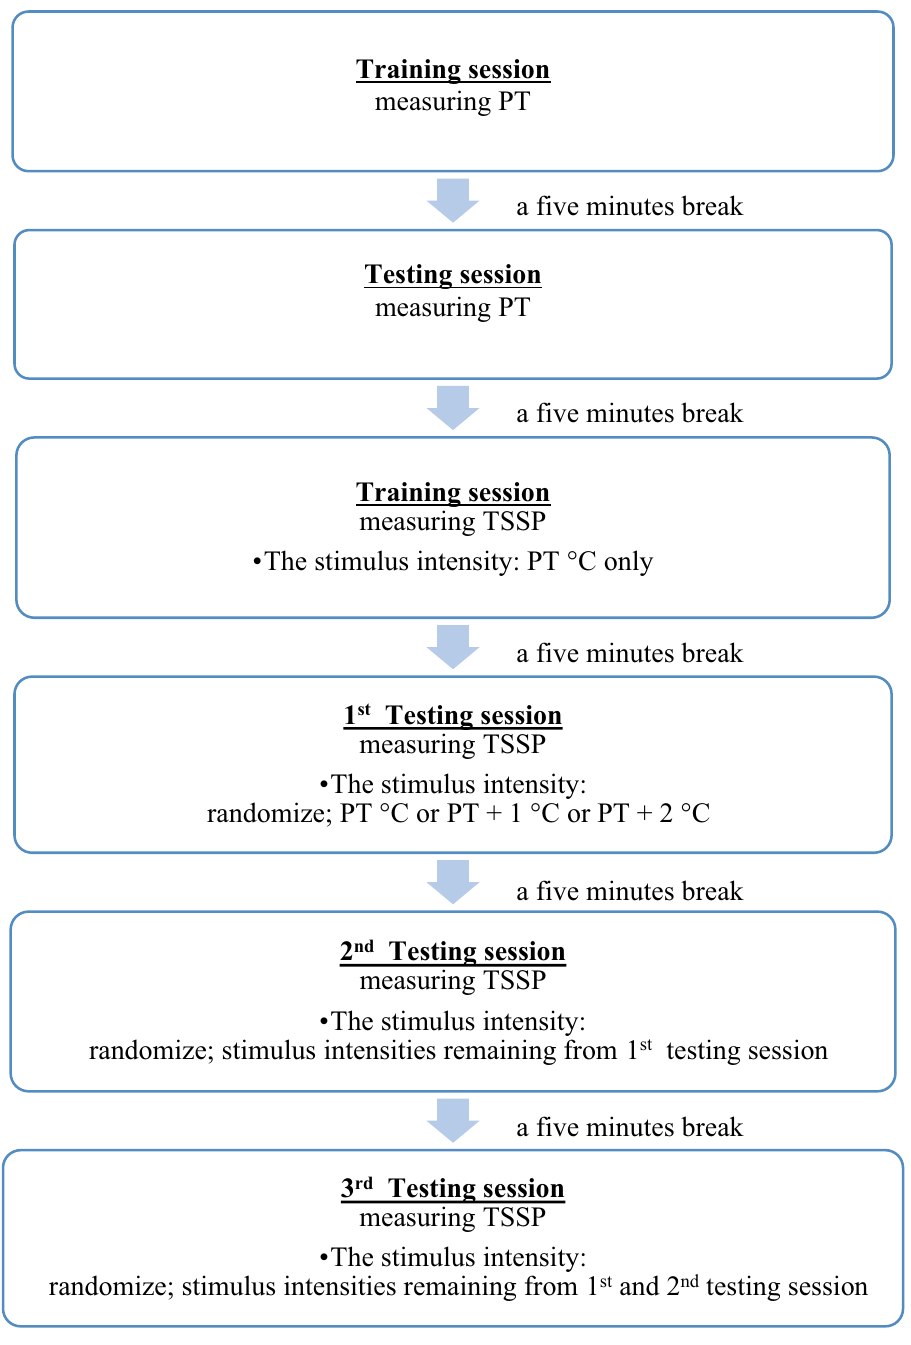
Figure 1. Flow chart of a protocol for measuring PT and